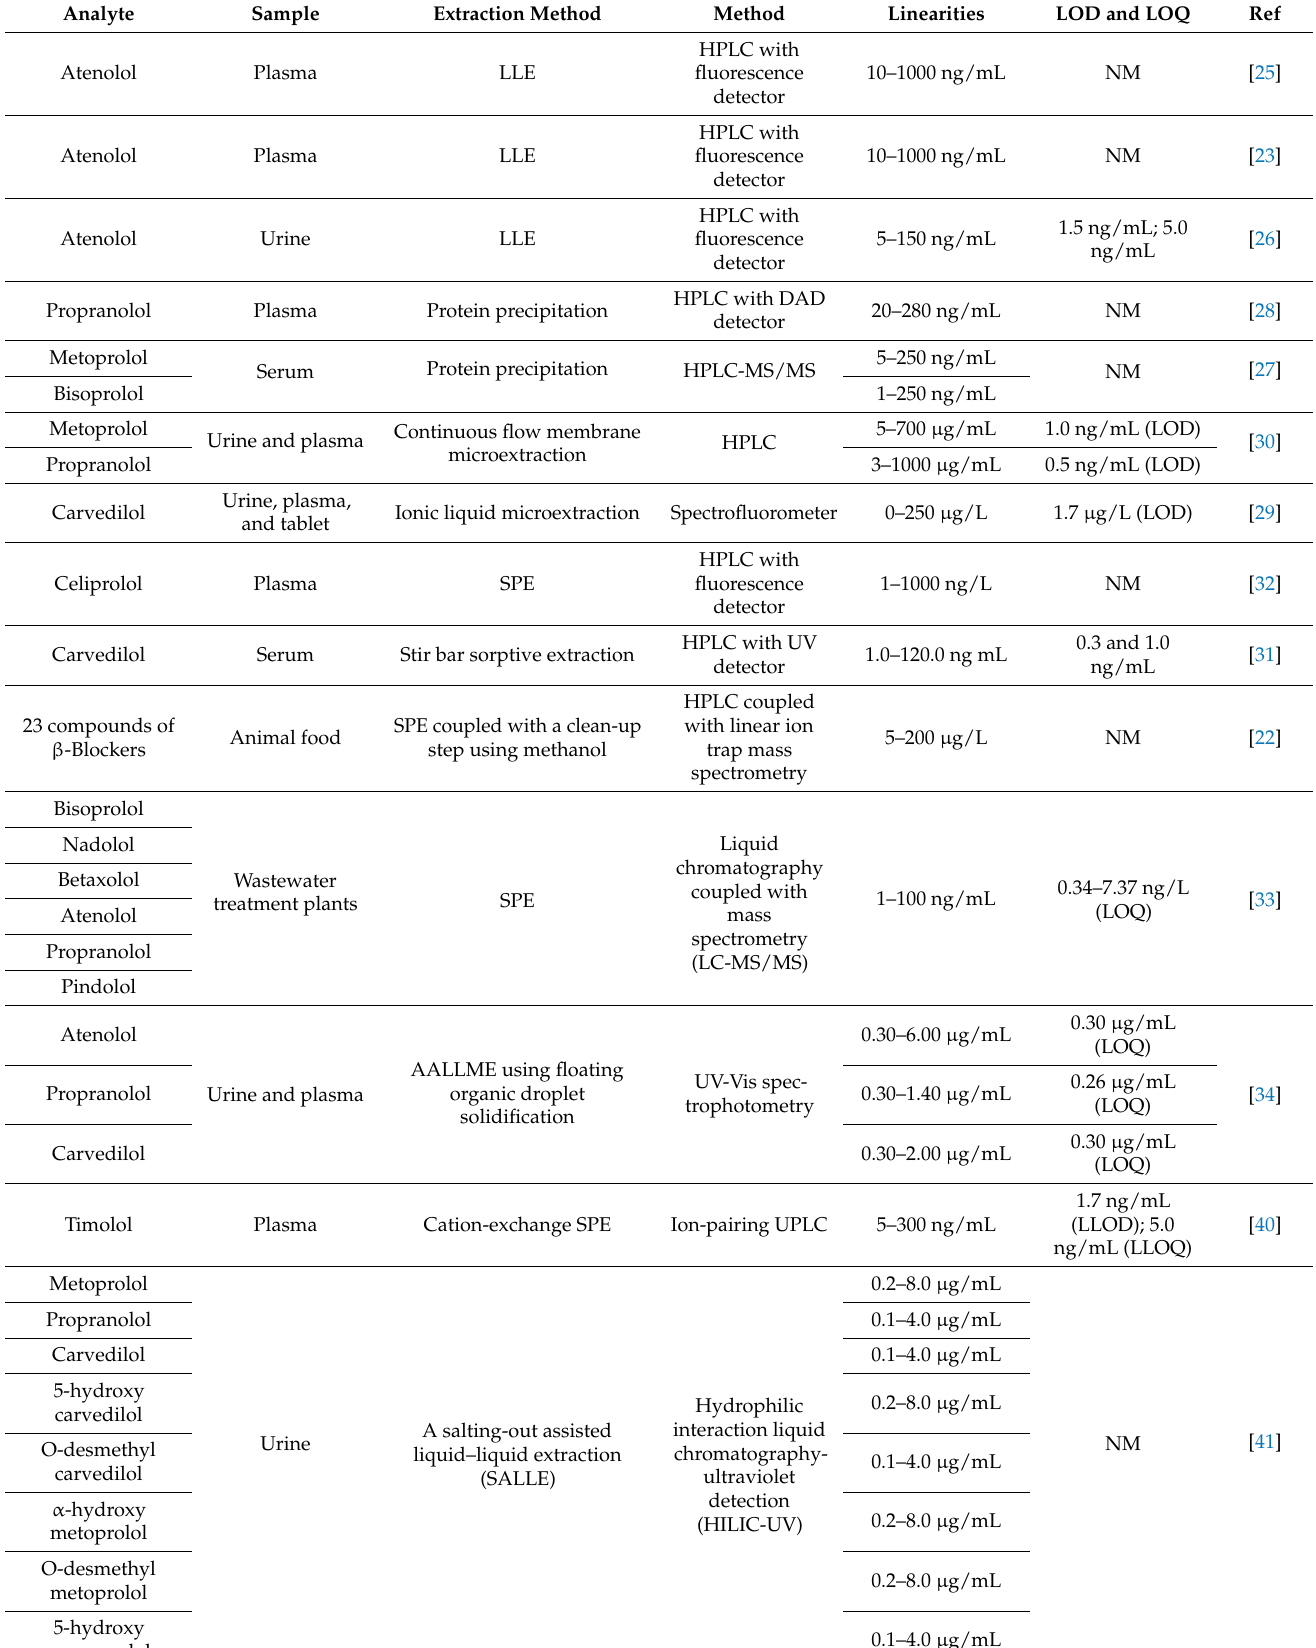
Table 2. Methods for the extraction of beta-blockers in different